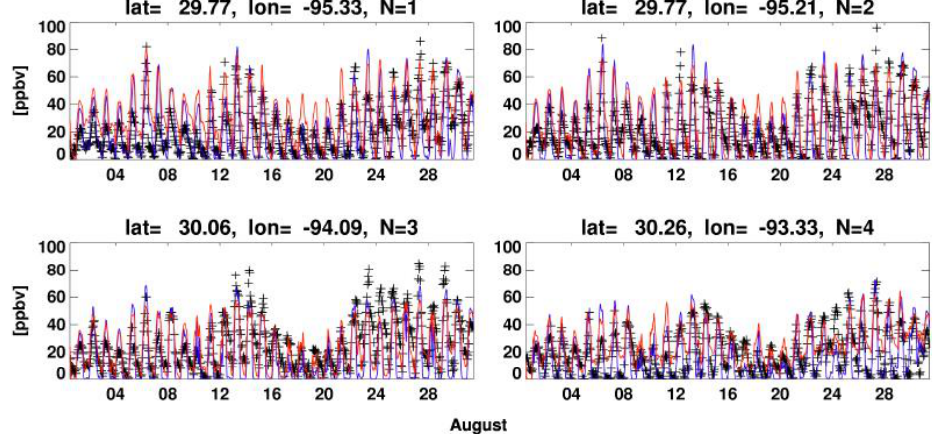
Fig. 10. Surface O 3 concentrations at EPA AQS stations (black crosses), corresponding baseline CMAQ simulations with baseline emissions, BASE2009 (blue), and CMAQ simulations with GOME-2-adjusted NO x emissions, GOME2009 (red) at the four station grids (see the right panel of Fig. 7, 1: Houston A, 2: Houston B, 3: Beaumont, and 4: Sulphur) in August 2009. Table 5. The number, the mean, and the standard deviation of the EPA AQS NO x observations (in ppbv), CMAQ NO x simulations with the baseline emissions, BASE2009 and CMAQ NO x simulations with GOME-2 adjusted emissions, GOME2009 at the four different EPA AQS measurement sites (see the right panel of Fig. 7, 1: Houston A, 2: Houston B, 3: Beaumont, and 4: Sulphur). CMAQ with BASE2009 (O 3 ) CMAQ with GOME2009 (O 3 ) EPA AQS (O 3 ) N mean σ mean σ mean